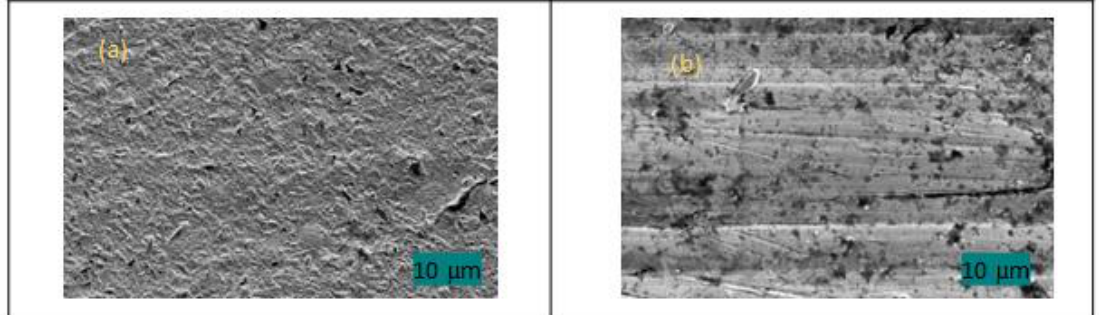
Figure 10. ( a ) Plain Pin Sample 1 The SEM image of untreated pins. ( b ) Plain pin sample 2 The SEM image of untreated pins. image of untreated pins.